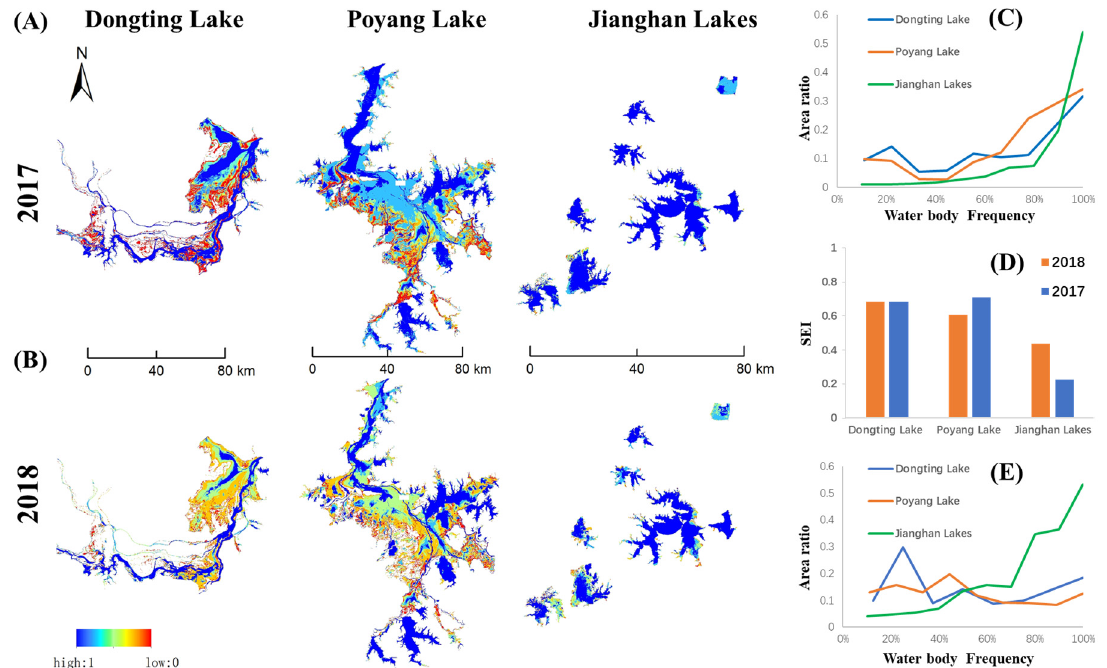
Figure 4. Water body frequency maps for DT, PY, and JH in 2017 ( A ) and 2018 ( B ). ( C ) Area ratio of water body frequencies for PY, DT, and JH in 2017 ( C ) and 2018 ( E ). ( D ) Submerged elasticity index (SEI) for DT, PY, and JH in 2017 and 2018.